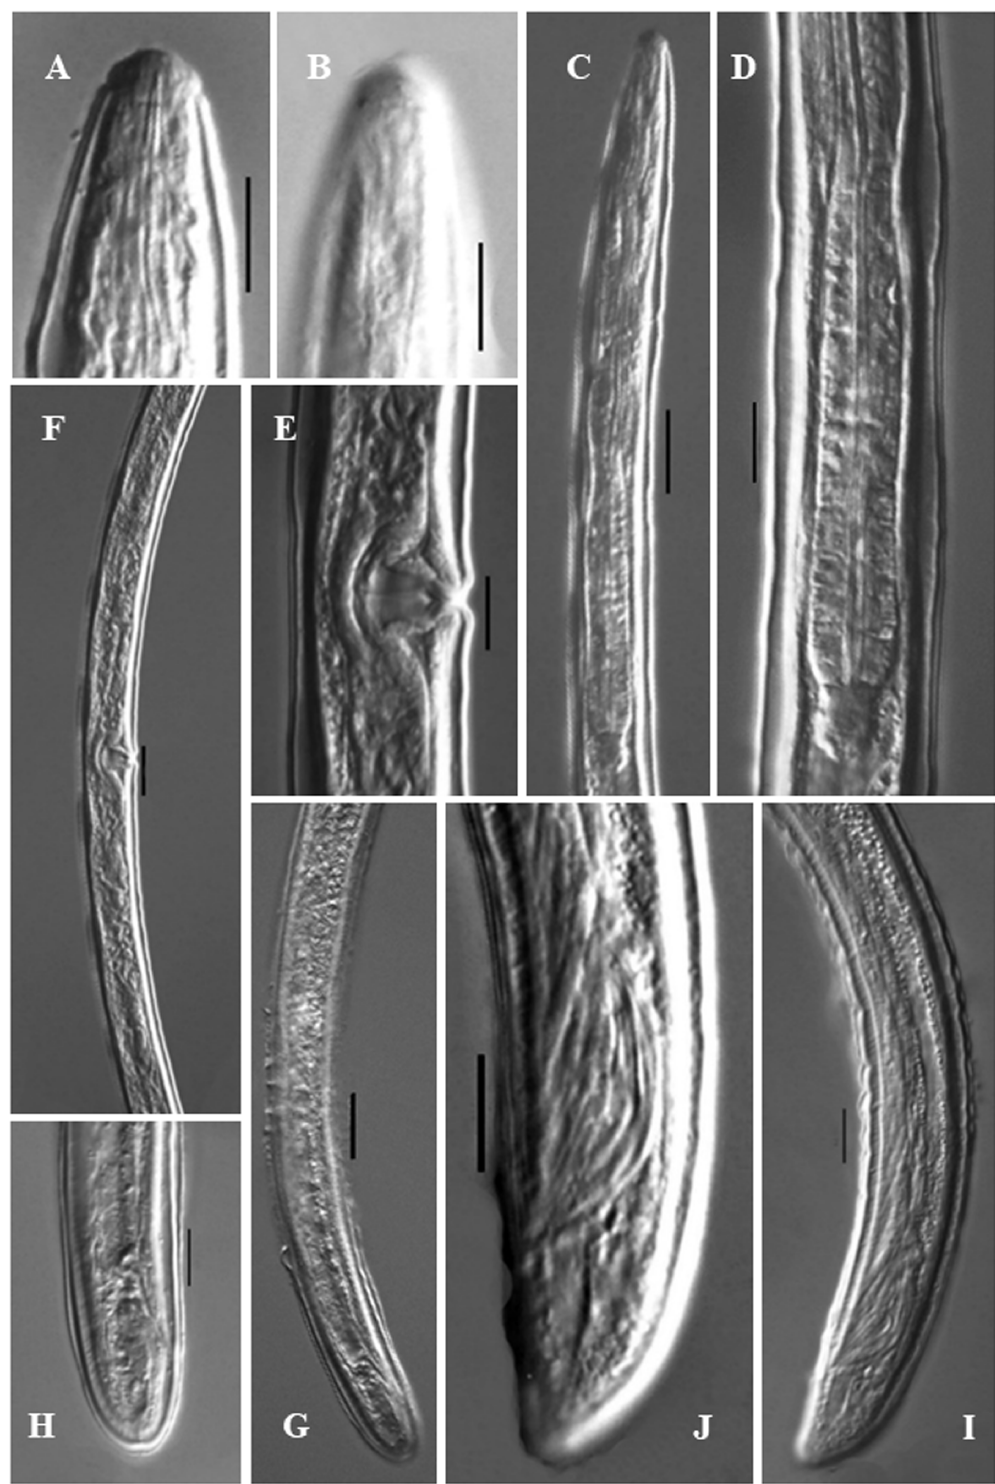
Fig. 3. Tylencholaimus teres Thorne, 1939 (LM photographs). A . Female anterior region. B . Female anterior region showing amphid. C . Male pharyngeal region. D . Male expanded part of pharynx. E . Vulval region. F . Female genital system. G . Female posterior region. H . Female posterior end. I . Male posterior region. J . Male posterior end. Scale bars: A–B, D–E, H–J = 10 μm; C, F–G = 20